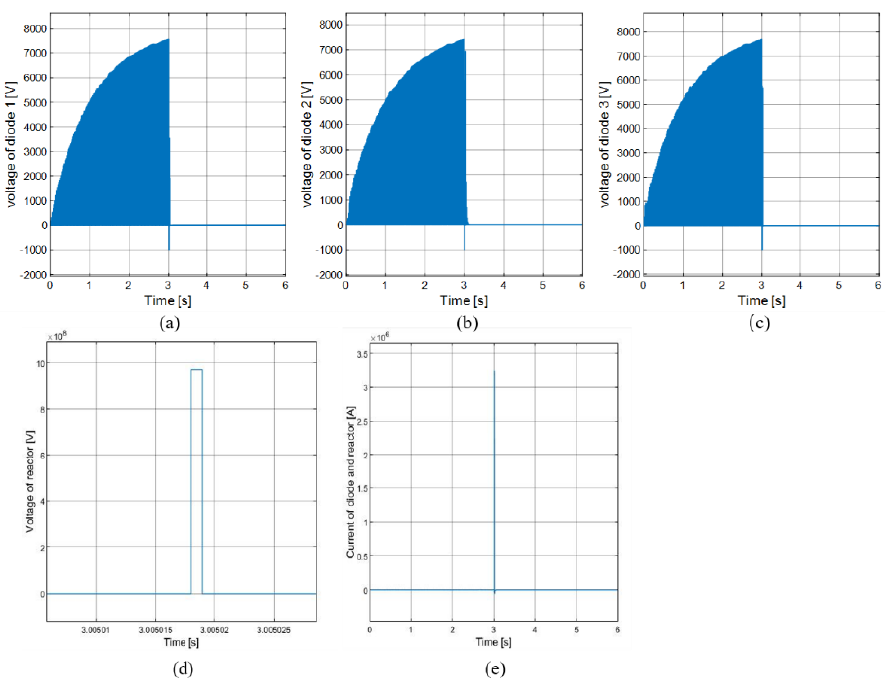
Figure 14. Voltage and current waveform on the series diode and reactor after the fuse is added: ( a ) voltage of diode 1; ( b ) voltage of diode 2; ( c ) voltage of diode 3; ( d ) voltage of reactor; ( e ) current of the series diode and reactor.